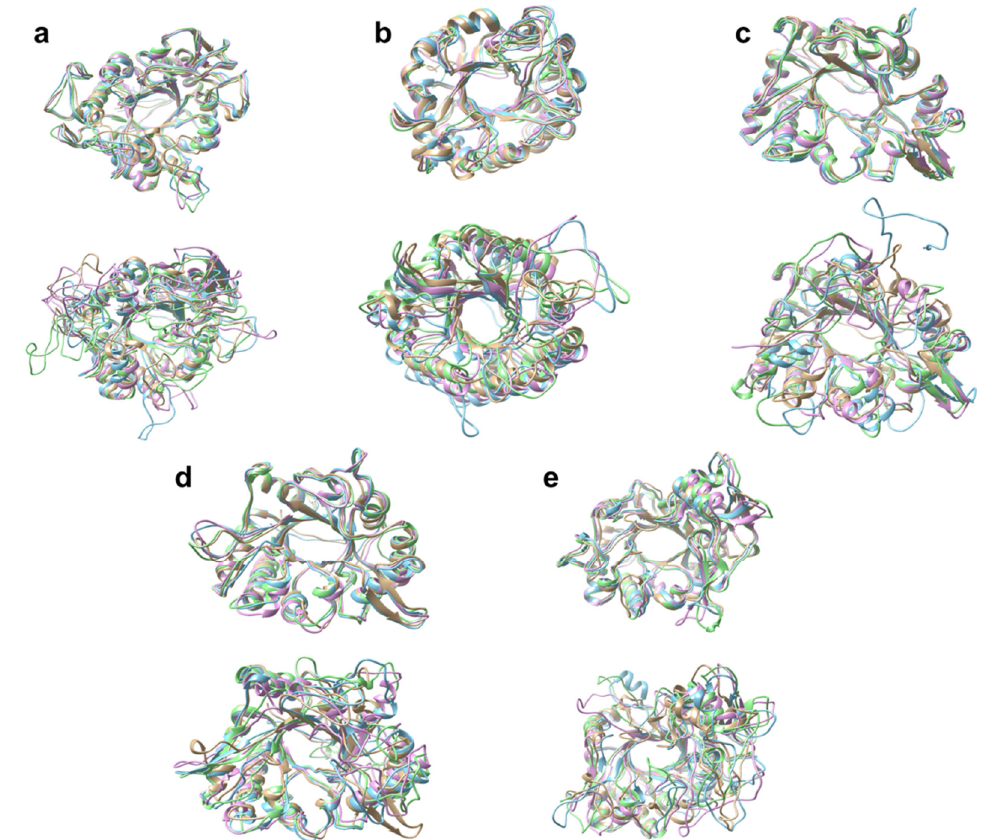
Figure 7. Superimposition of the frames extracted from the 300 K (upper row) and 400 K (lower row) trajectories at 0 ns (brown), 100 ns (blue), 200 ns (purple), and 300 ns (green): ( a ) P-As, ( b ) T-Pf, ( c ) M-Sm, ( d ) P-Mm, and ( e ) M-Sp. Occlusion of the central cavity by adjacent loops was evident in the 400 K structures of P-As and P-Mm, and to a lesser extent in M-Sm and M-Sp, whereas T-Pf retained its structure. The RMS deviations at 400 K between 0 ns and 300 ns were 1.259, 1.021, 1.266, 1.207, and 1.133 Å,